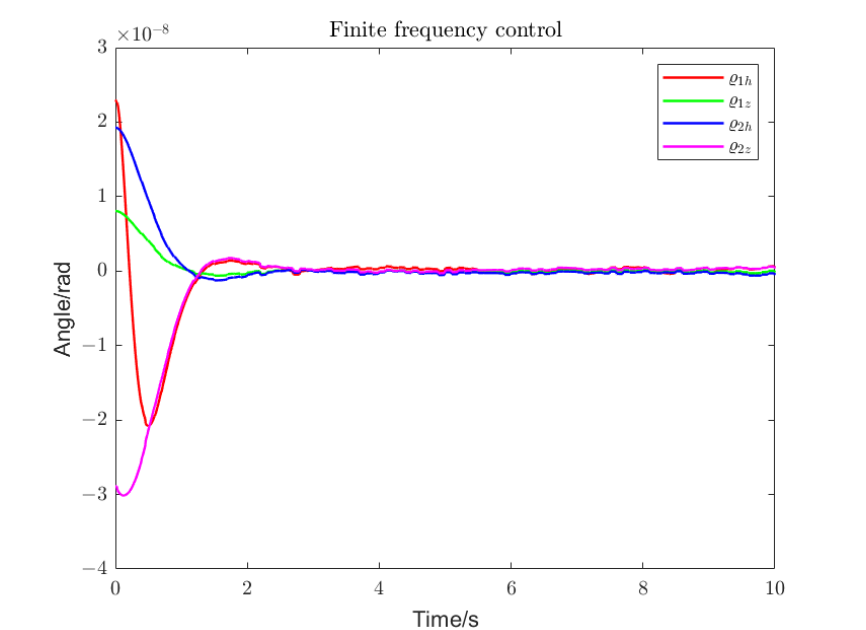
Figure 10. Pointing error of the telescope (finite frequency control). With finite frequency control, the LOS attitude deviation of the pitch angle and the yaw angle under various disturbances can reach a stable state within 3